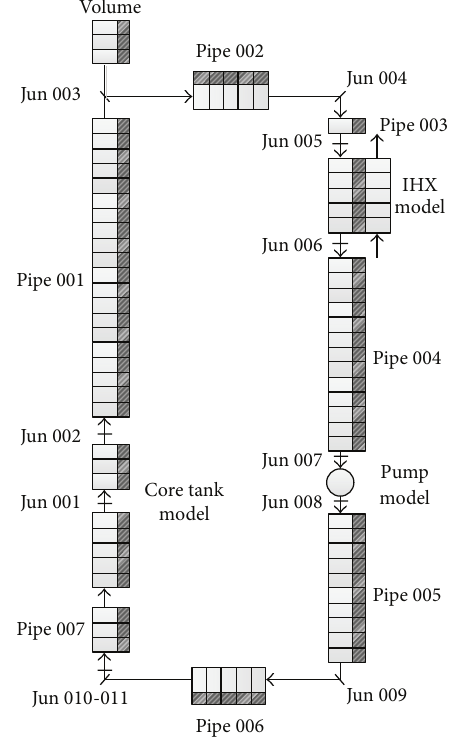
Figure 4: Nodalization of the